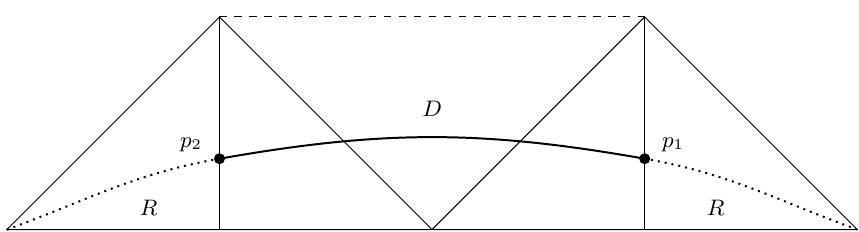
Figure 2 . The calculation of the entropy of the baths region to the AdS region involves calculating a CFT entanglement entropy for an interval D across the AdS region between boundary points at a given time t